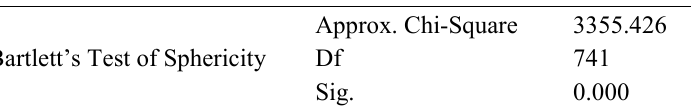
Table 4. KMO and Bartlett's Test for Factors Affecting